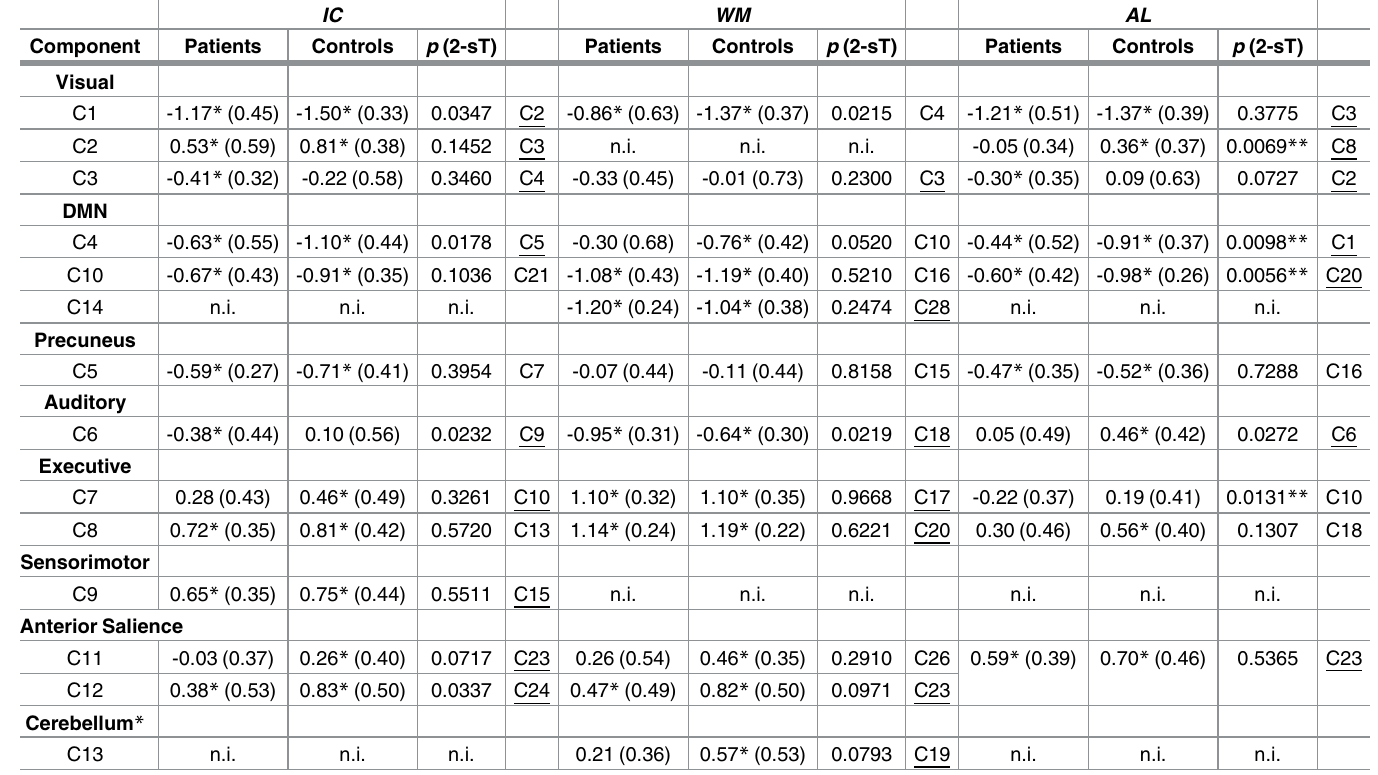
Table 3. Beta weight values ( mean ( SD )) of the spatially matched components for each task. IC WM